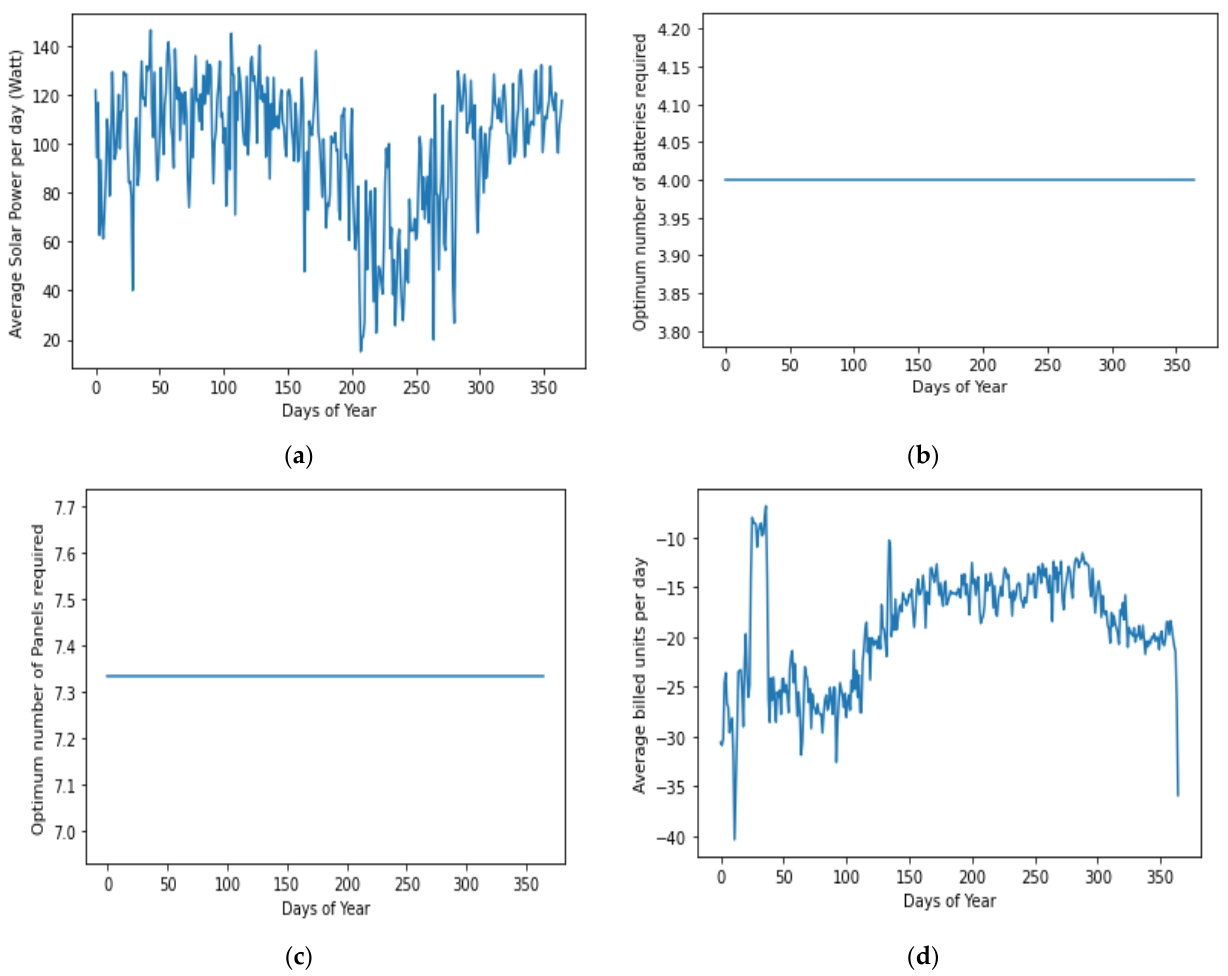
Figure 4. ( a ) Average solar panel power per month; ( b ) optimum no. of required batteries; ( c ) optimum no. of required solar panels; ( d ) avg. expected electricity.